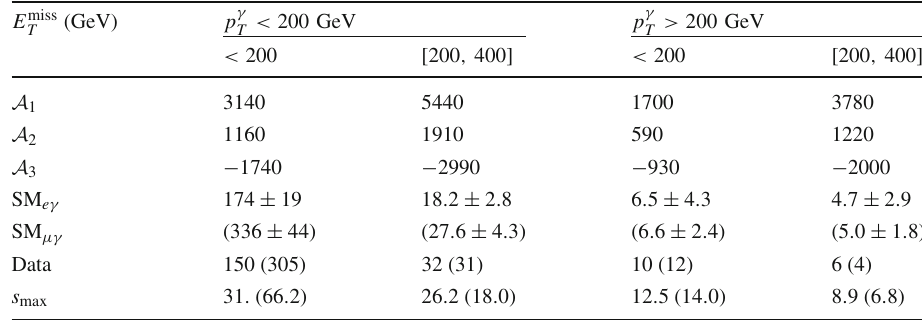
Table 3 CMS lepton